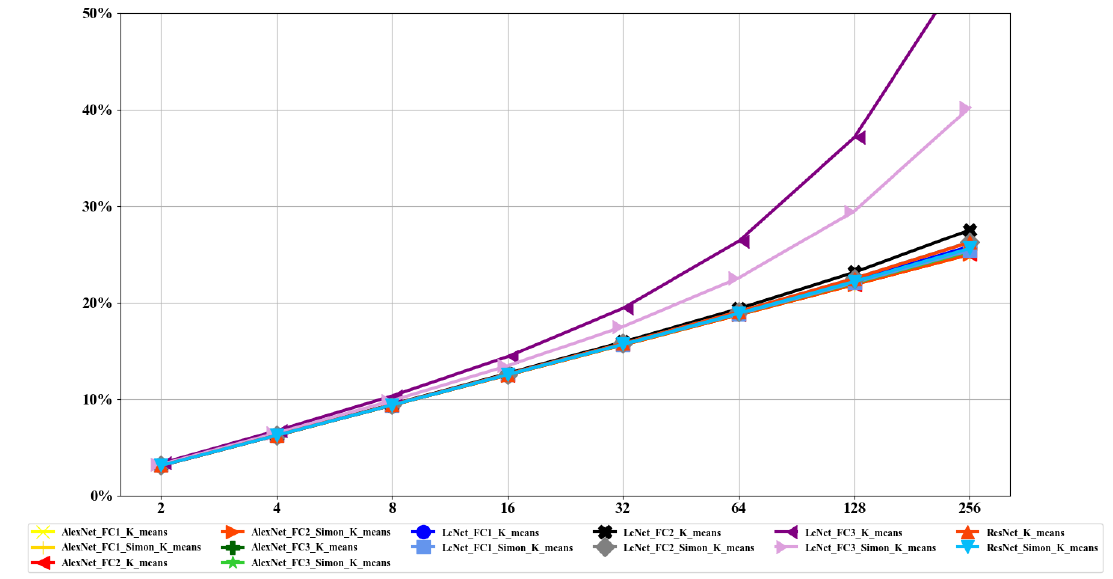
Figure 9. Compression ratio of fully connected layers of the neural network with different values of k .